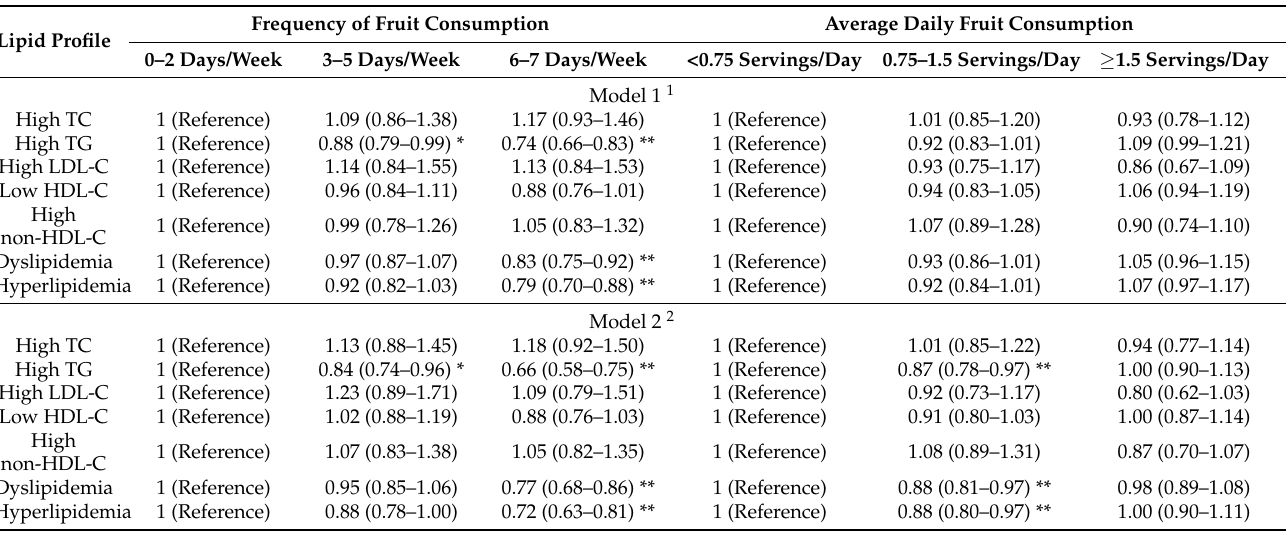
Table 2. Multivariate odds ratios (OR) and 95% confidence intervals (CI) of fruit consumption and lipid profile ( n = 14,755).